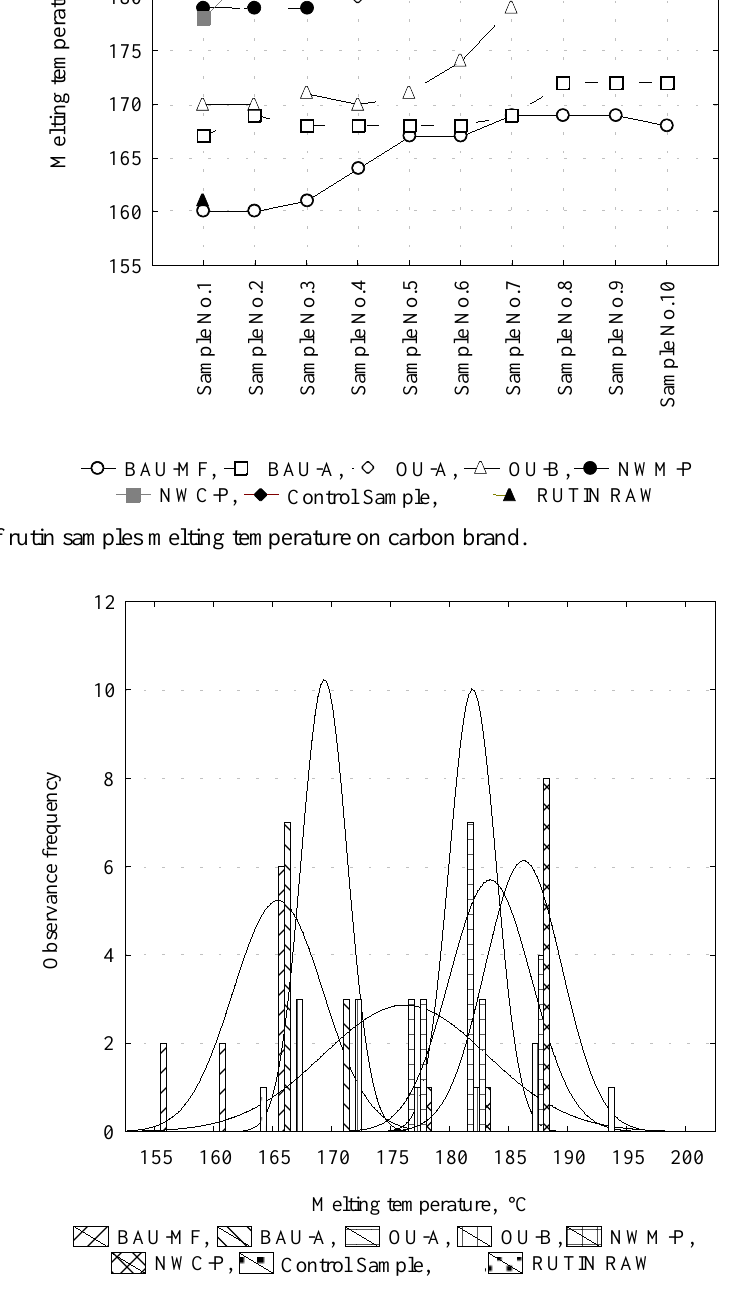
Fig. 2. Normal distribution of melting temperature values of rutin samples depending on carbon